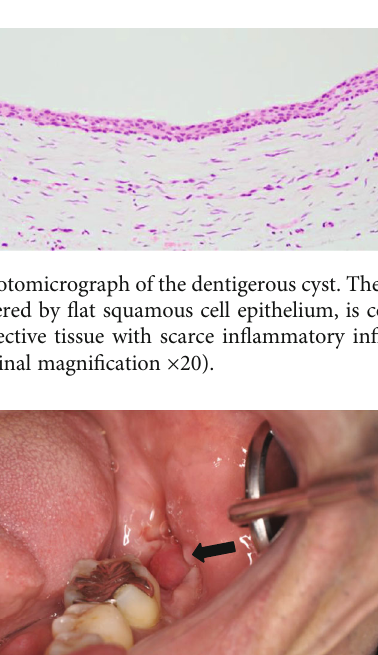
Figure 1: Photoradiograph of the impaction of the left mandibular wisdom tooth and surrounding cystic radiolucent image: (a) orthopantomogram; (b) computed tomography of axial image; (c) computed tomography of sagittal image.